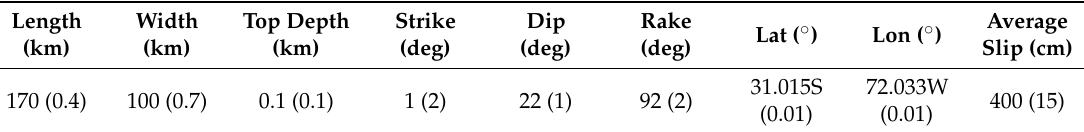
Table 1. Analytical fault model parameters retrieved through non-linear inversion, with the relative standard deviation in